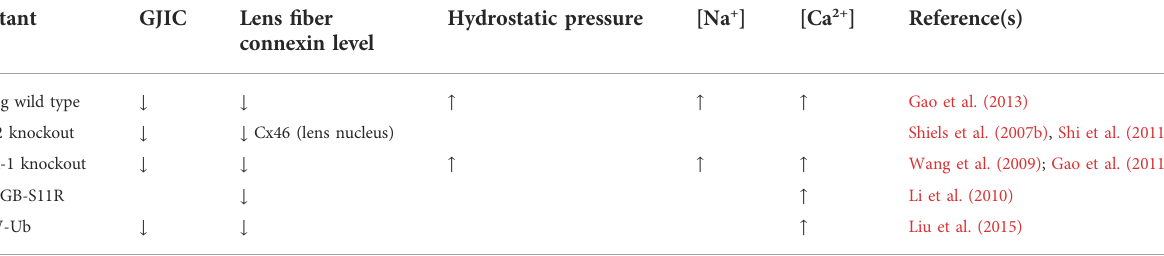
TABLE 1 Mouse models with alterations of fi ber cell gap junction-mediated intercellular communication (GJIC) and/or levels of fi ber cell connexins. Mutant